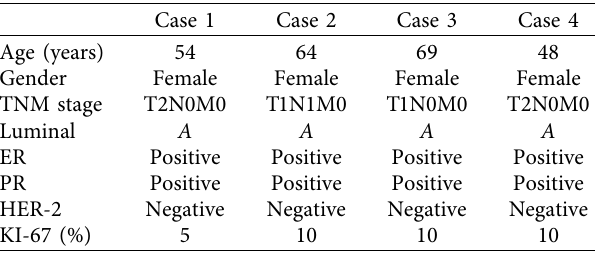
ER: Estrogen receptor; PR: progesterone receptor; HER-2: epidermal growth factor receptor; KI-67: rabbit monoclonal antibody against human proliferating nuclear